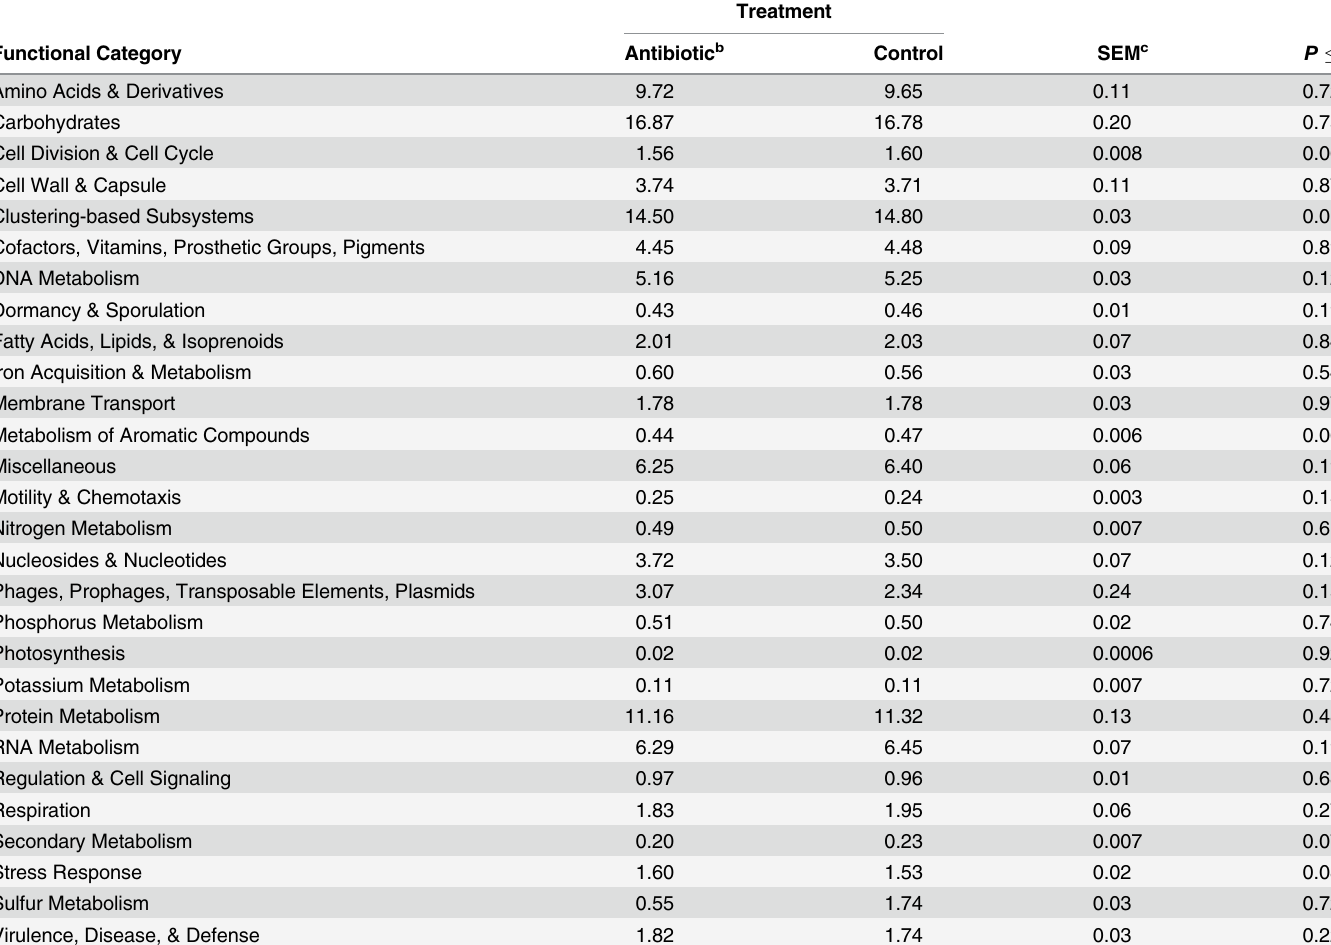
Table 1. Effect of ceftiofur crystalline-free acid antibiotic treatment on the abundance of microbial cell functions in dairy cow feces a .